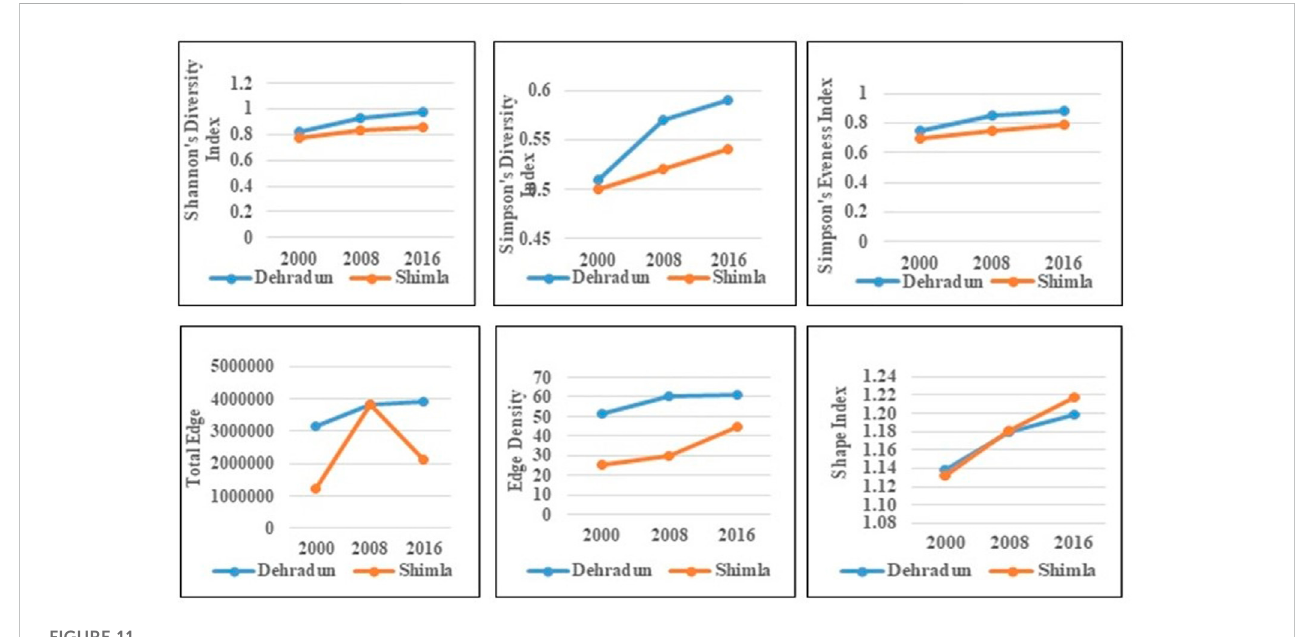
FIGURE 11 Changes in spatial metrics at landscape level for Dehradun and